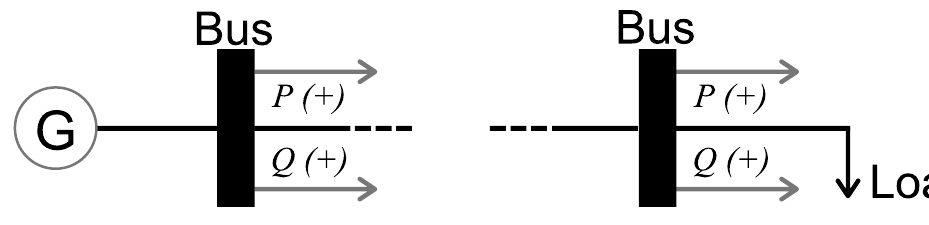
Figure 9. Sign convention for analyses.